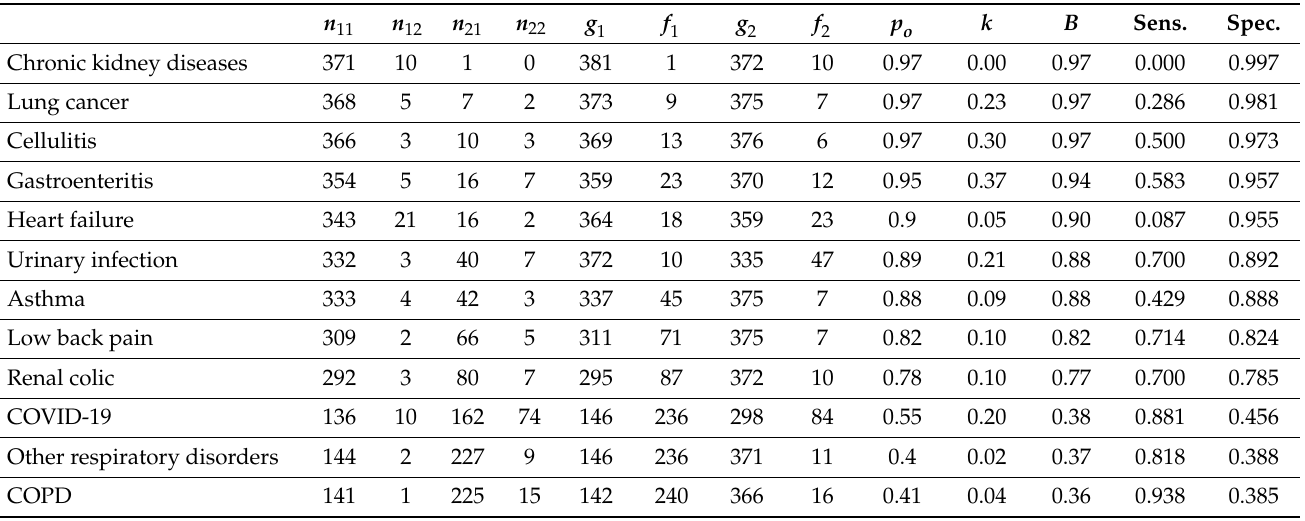
Table 3. Observed concordance, Kappa, and B statistics for the 12 most frequent diagnostics at hospital discharge (ordered for B statistics).